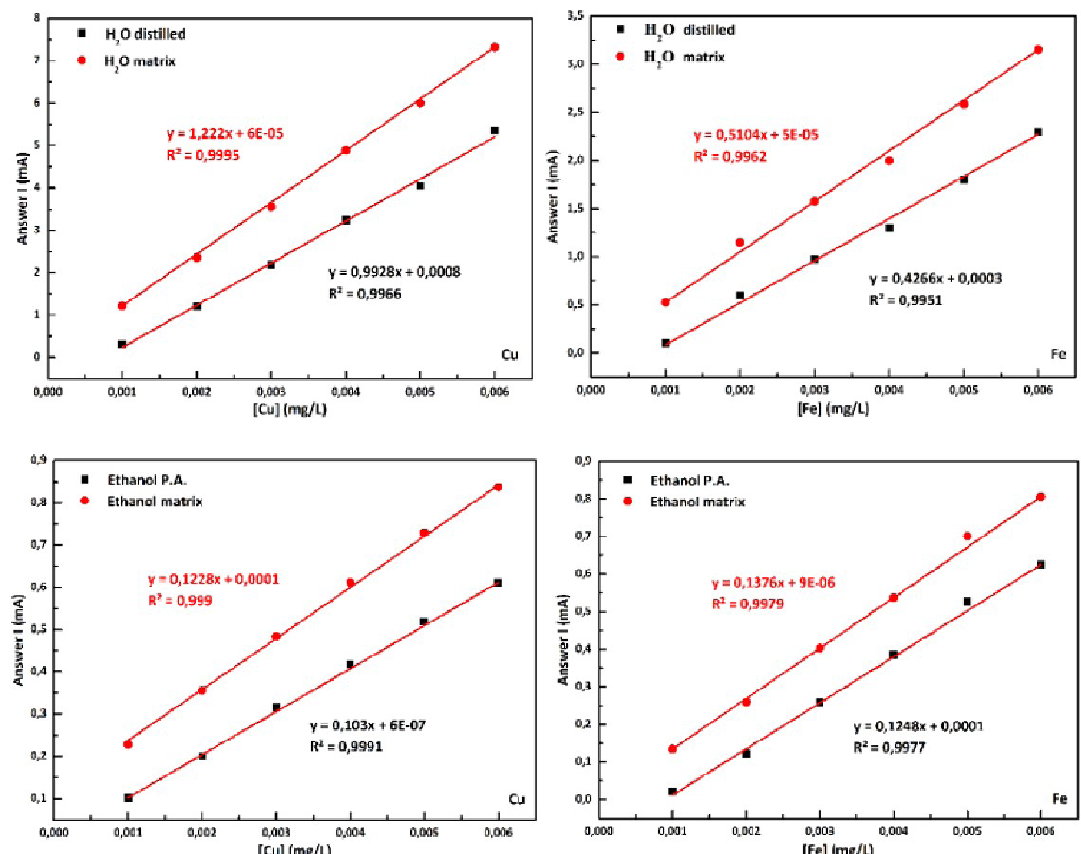
Figure 4. Analytical curves constructed from stock solution of copper (Cu 2+ ) and iron (Fe 3+ ) using a working range of 0.001 mg L -1 to 0.006 mg L -1 for aqueous and ethanolic medium, varying the electrochemical parameters.